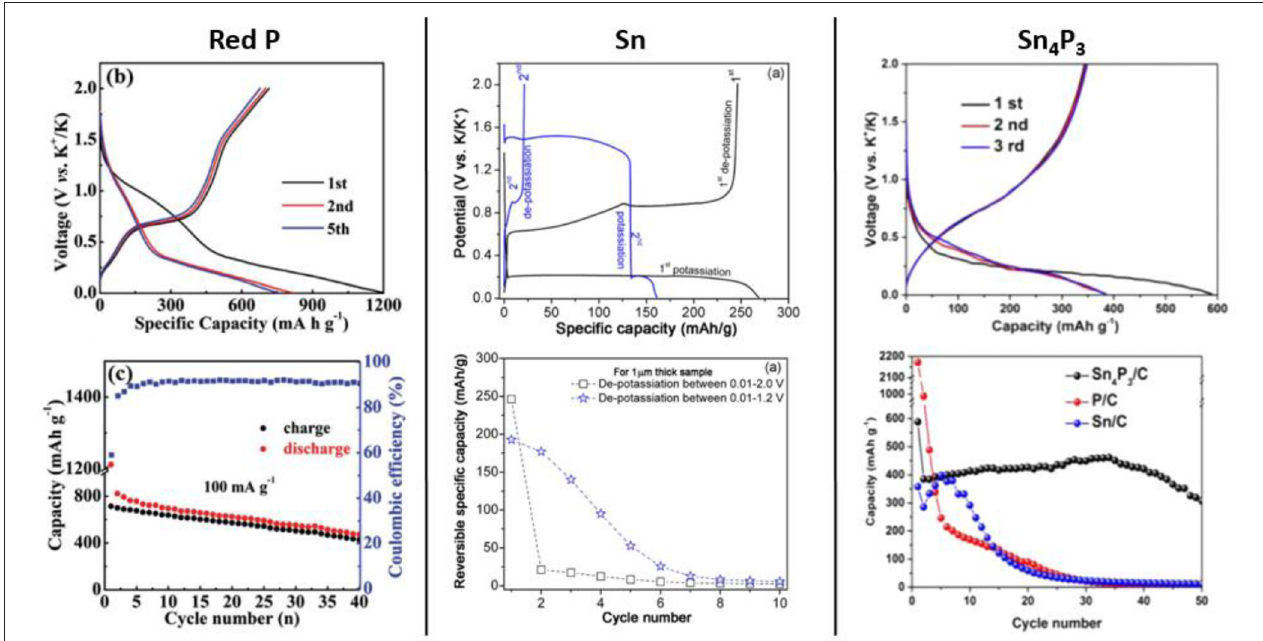
FIGURE 7 | Galvanostatic profiles and capacity retention of red P@CN composite (left), Sn electrode prepared by e-beam evaporation process (middle), and ball milled Sn 4 P 3 /C (right). Reprinted with permission from Zhang W. et al. (2017) Copyright (2018) American Chemical Society, from Xiong et al. (2018b). Copyright (2018) WILEY-VCH Verlag GmbH & Co. KGaA, Weinheim, and from J. Electrochem. Soc., 164, 12360 (2017). Copyright 2017, The Electrochemical